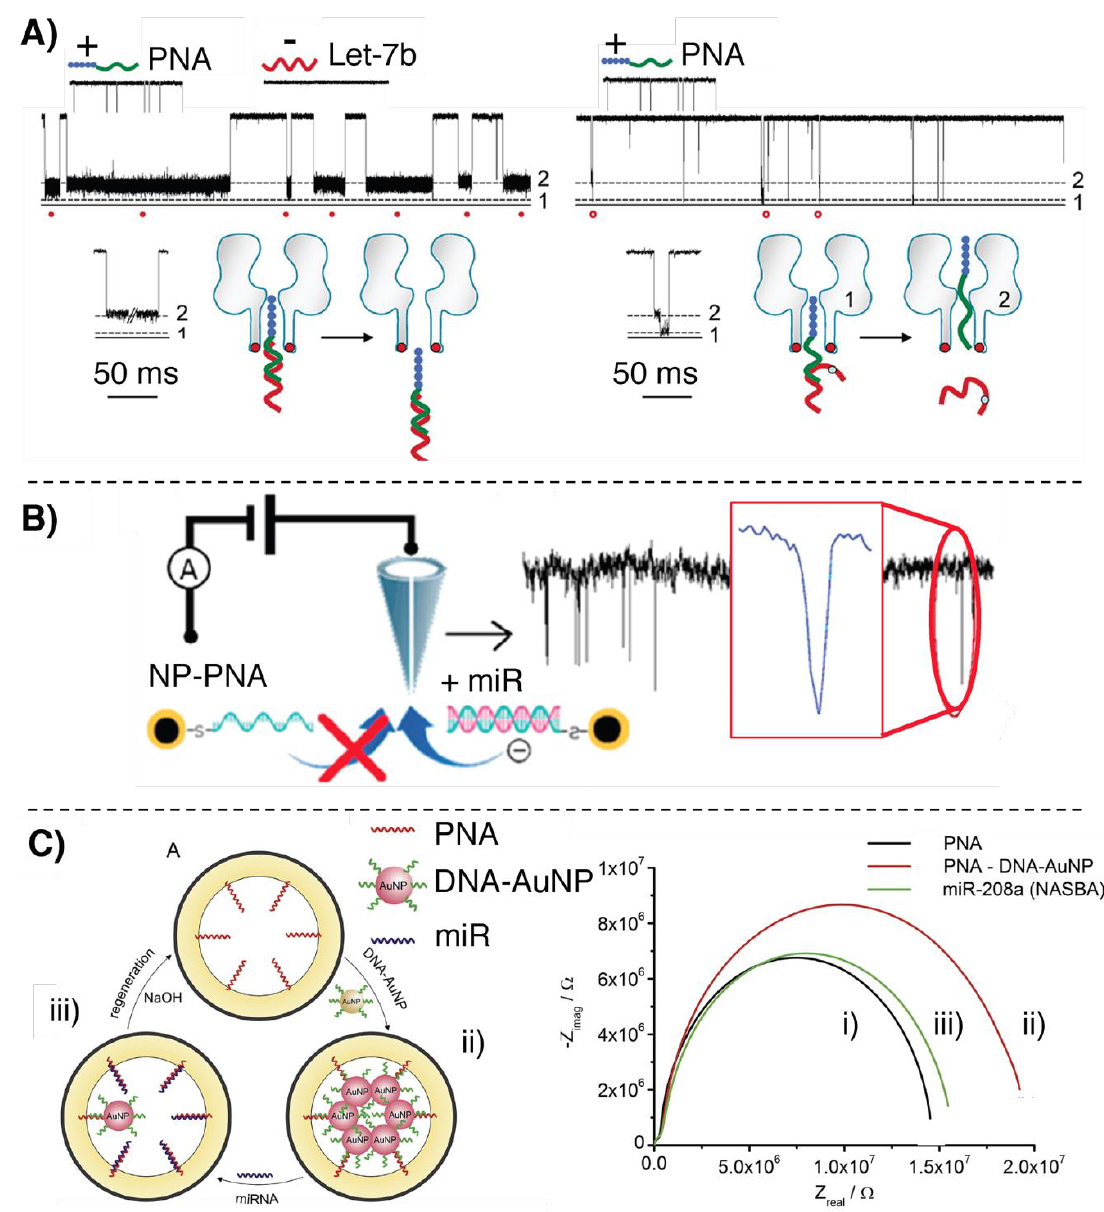
Figure 3. Illustration of the nanopore-based methodologies for miR detection relying on PNAs. ( A ) Nanopore sensing of let-7b, adapted with permission from [65]. Copyright 2013 American Chemical Society ( B ) Nanopore-based sensing of miR-21, adapted with permission from [66]. Copyright 2019 American Chemical Society ( C ) AuNP-displacement based biosensor described in [68].